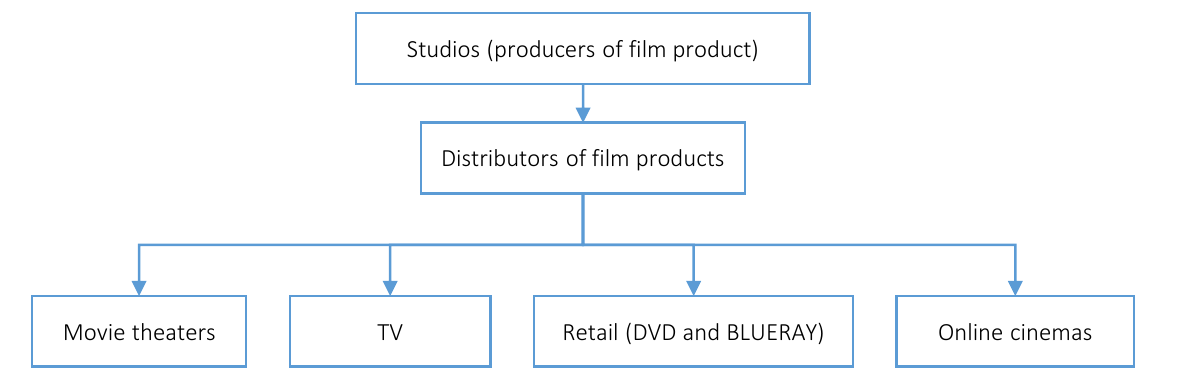
Source: Developed by the